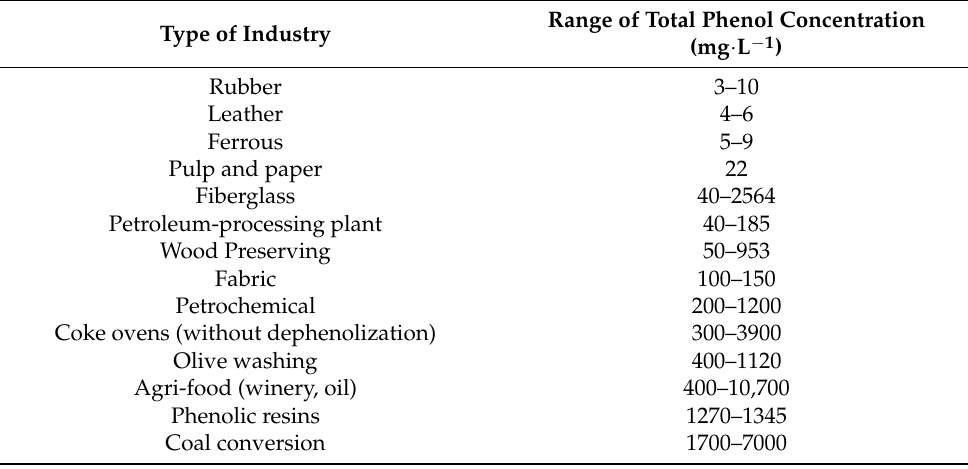
Table 1. Phenol levels in industrial wastewaters